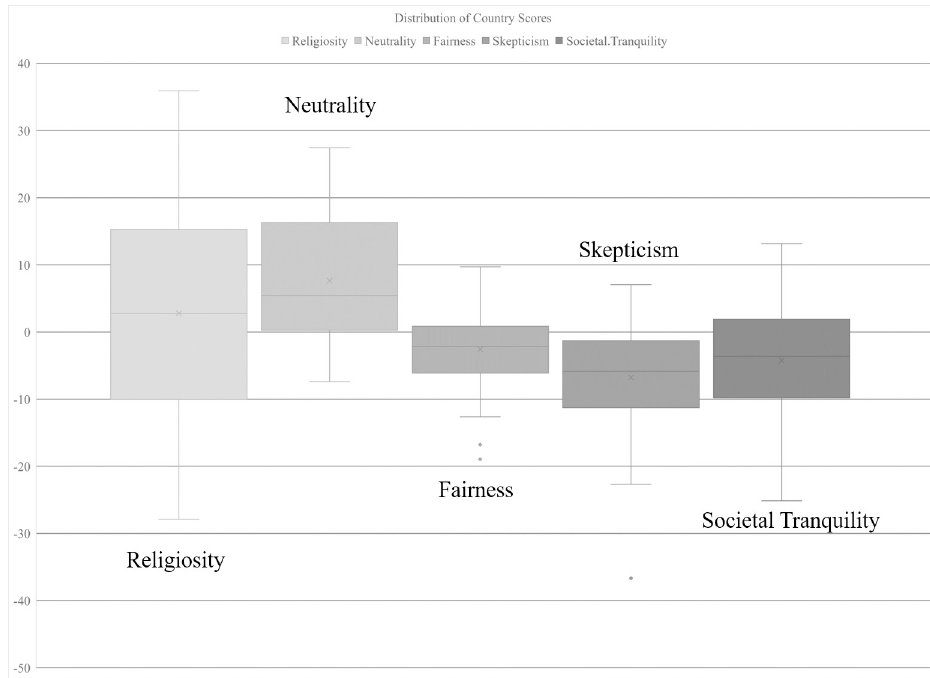
Fig 2. Distribution of country scores on social